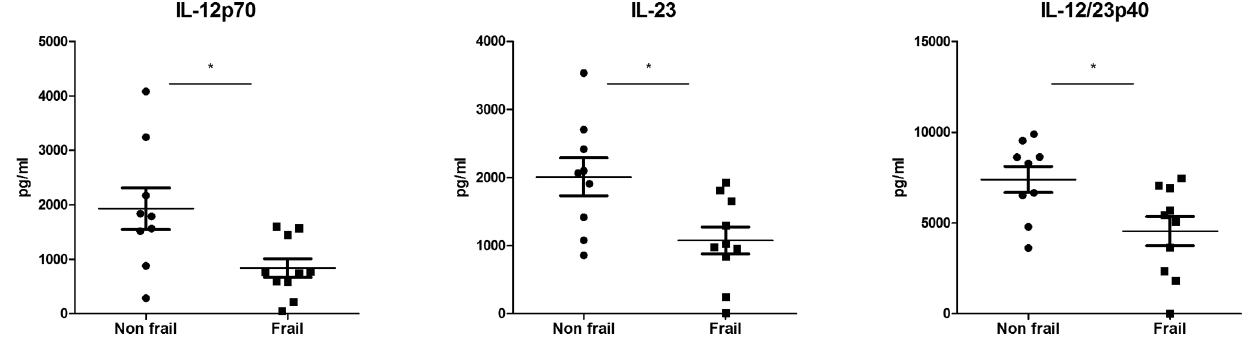
Figure 2. Decreased production of IL-23, IL-12p70 and IL-12/23p40 in response to LPS + R848 stimulation in a subgroup of frail old individuals. Whole blood cells from frail (n=10) and non frail (n=9) old individuals were stimulated with LPS + R848 during 24 h. IL-12/23p40, IL- 12p70 and IL-23 were measured in cell-free supernatants by ELISA. Each dot represents a single donor and the bars represent median values 6 interquartile range. *p , 0.05.